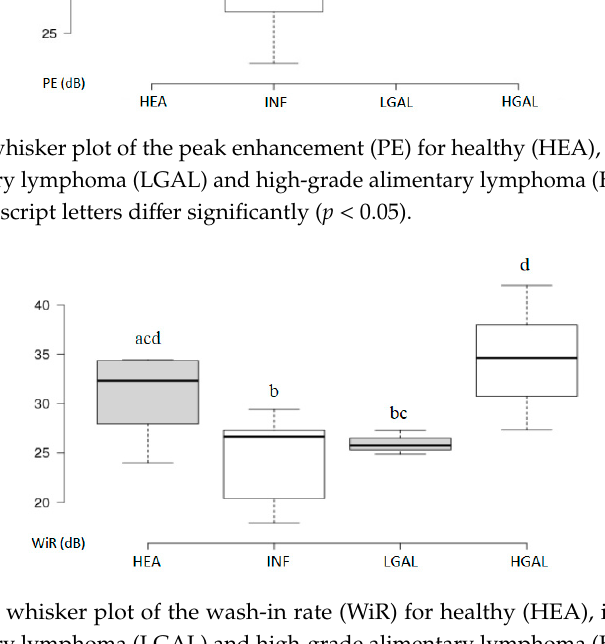
Figure 10. Box and whisker plot of the wash-in rate (WiR) for healthy (HEA), inflammatory (INF), low-grade alimentary lymphoma (LGAL) and high-grade alimentary lymphoma (HGAL). a,b,c,d Values with different superscript letters differ significantly ( p < 0.05).